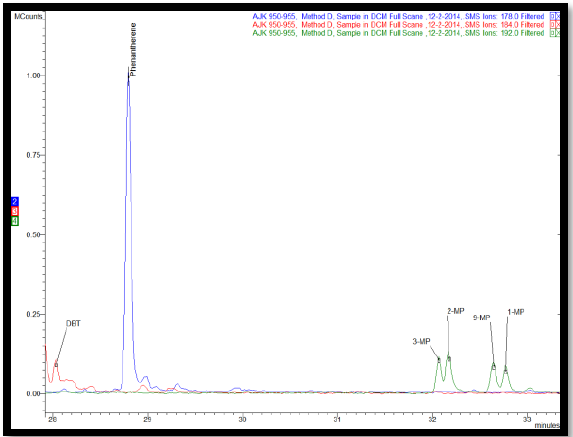
Figure 10: Chromatogram of Laki Formation shale extracts showing distribution of phenanthrene (m/z 178), alkyl phenanthrene (m/z 192) and dibenzofuran (m/z 184).